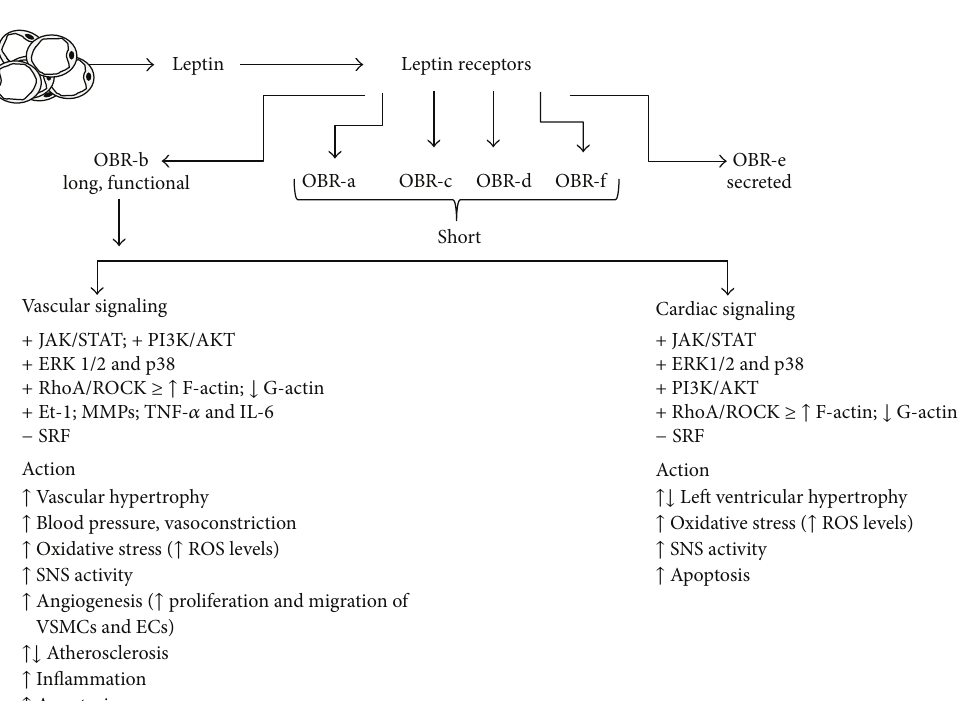
Figure 1: Summary of molecular signaling responses to leptin and their cardiac and vascular effect. ↑ or + represents activation of protein or effect whereas ↓ or − indicates inhibition. See text for more